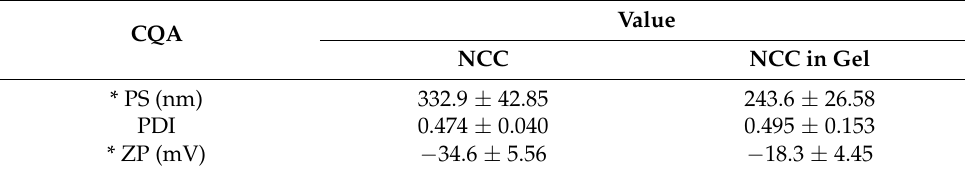
Table 6. Summary of critical quality attributes (CQA) of nano co-crystal (NCC).